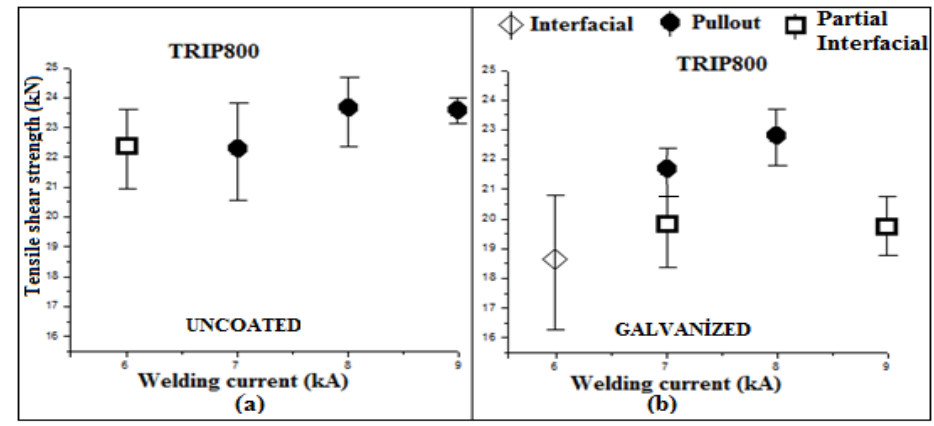
Figure 6. Effect of welding parameters on the tensile shear strength and failure types: ( a ) uncoated; ( b ) galvanized.